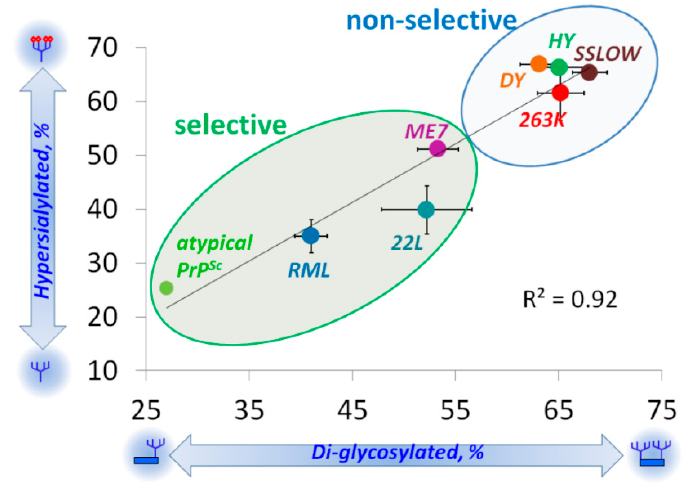
Figure 3. Correlation between strain-specific sialylation status and glycoform ratio. Strain-specific percentages of diglycosylated glycoforms plotted as a function of strain-specific percentage of hypersialylated glycoforms within PrP Sc . Mean and standard deviations are shown (n = 3 animals). Black solid line shows the result of linear fitting of the percent of diglycosylated as a function of the percent of hypersialylated for brain-derived PrP Sc . Adapted from Katorcha et al. 2015 [37].